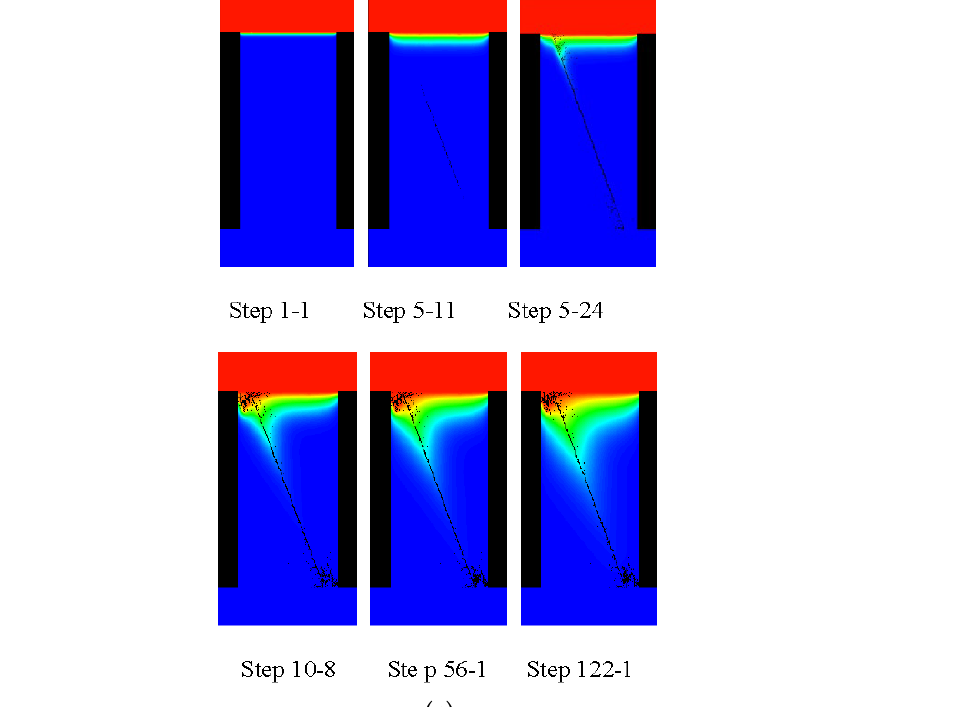
Figure 6. Numerical results of the cracked mode. ( a ) Whole process curve of load step-stress- permeability coefficient. ( b ) Stress results of the model failure process (MPa). ( c ) Results of water pressure distribution in the model failure process (m).